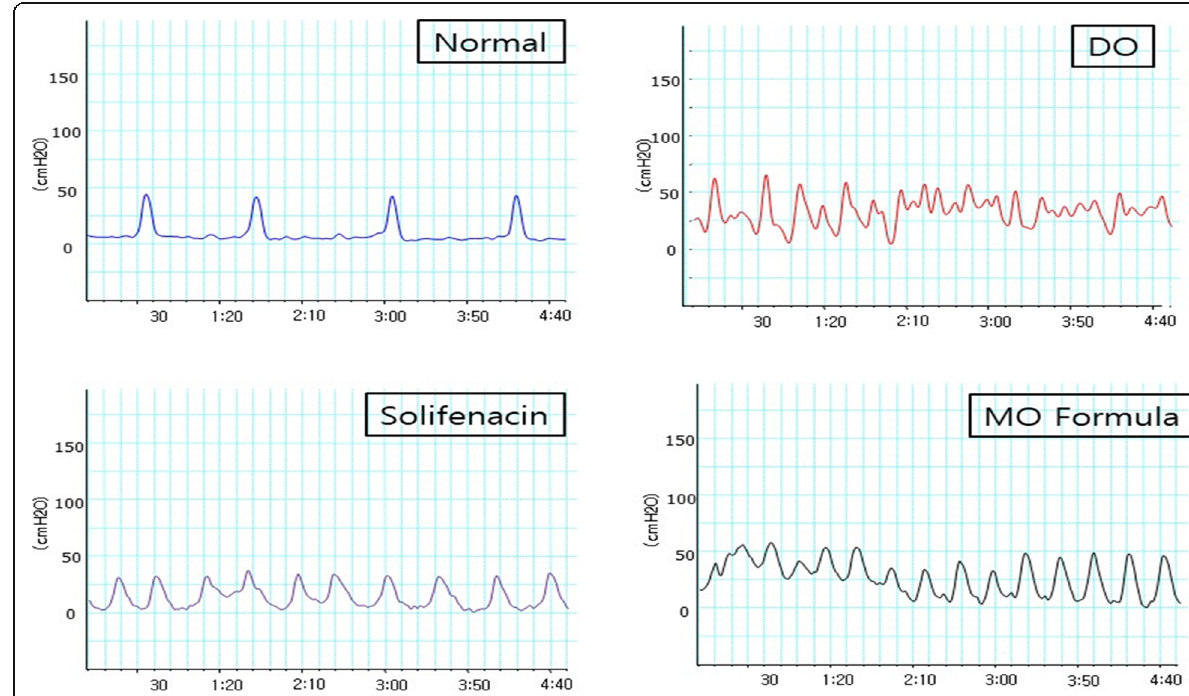
Fig. 1 CMG on each group. Normal (sham operation group) and for making detrusor overactivity model, After 2 weeks of partial urethral obstruction, detrusor overactive model was identified in